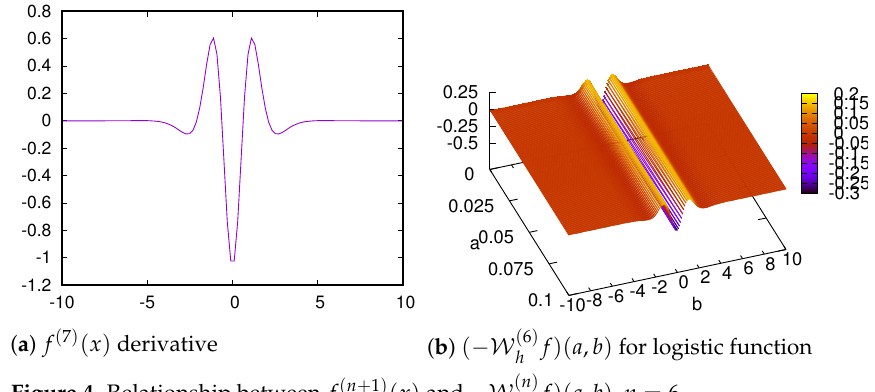
Figure 4. Relationship between f ( n + 1 ) ( x ) and −W